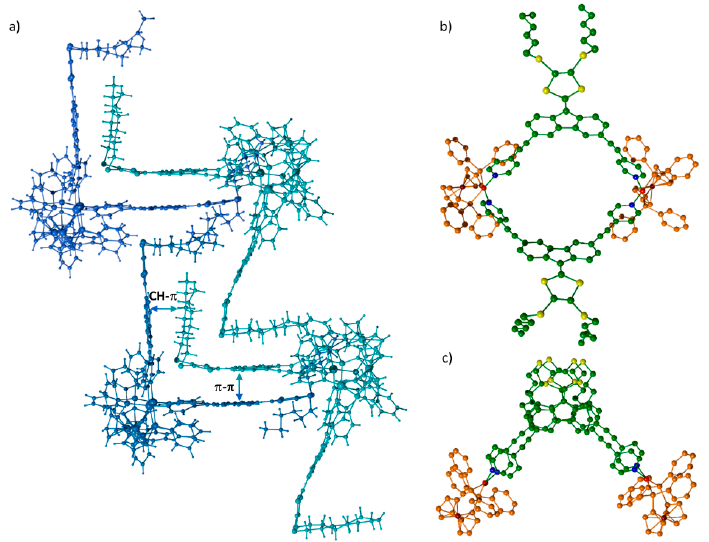
Figure 4. X-ray crystal structure of [ Pd 2 (L4Pyr) 2 (OTf) 4 ], ( a ) crystal packing showing two independent discrete assemblies (blue and turquoise respectively), ( b ) top view and ( c ) lateral view of turquoise metalla-macrocycle (related to ( a )). Counter anions, solvent molecules and hydrogen atoms ( b , c ) omitted for